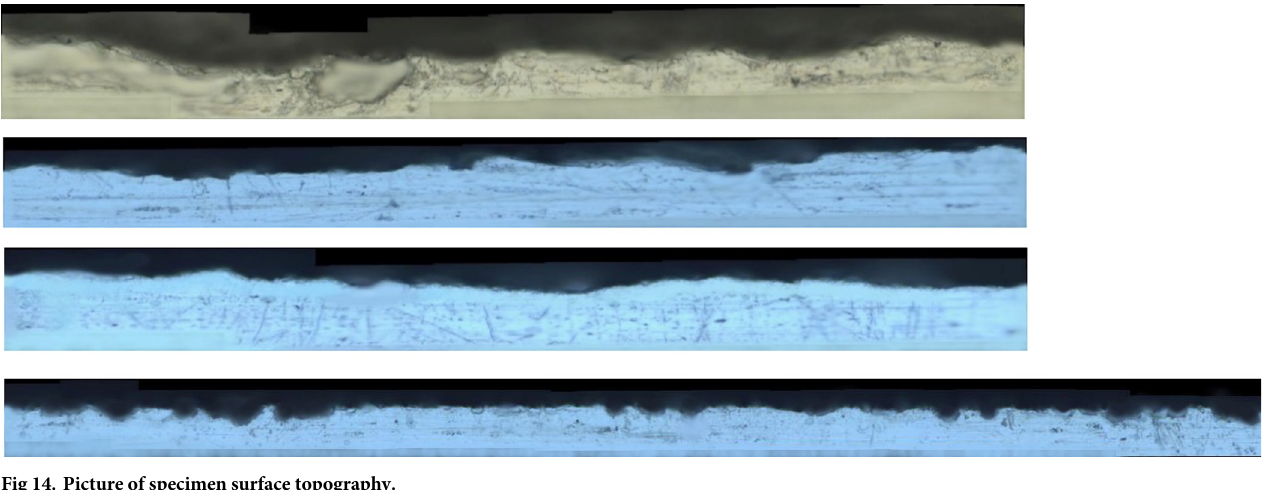
Fig 14. Picture of specimen surface